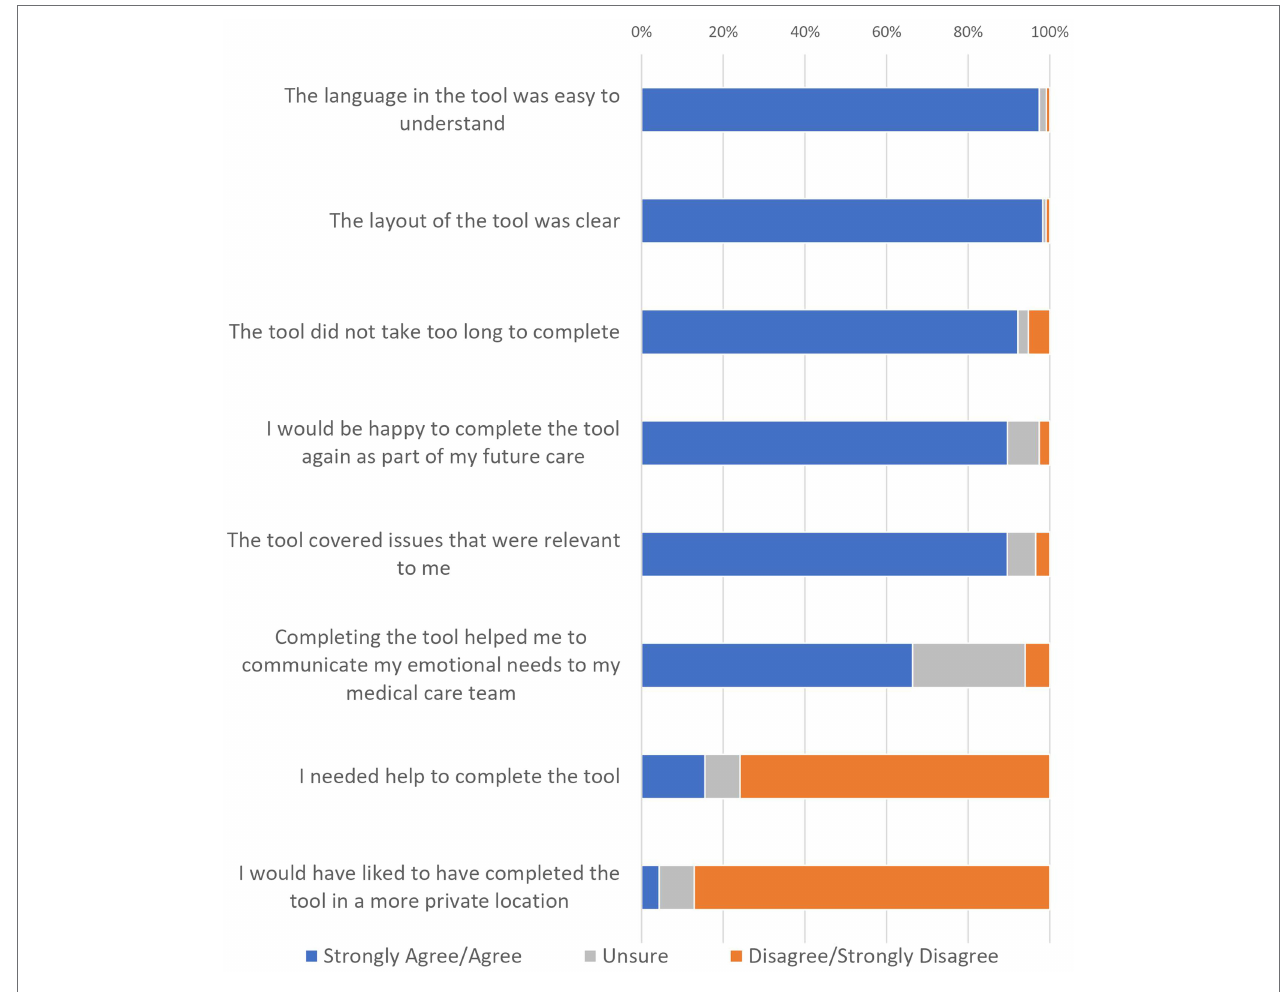
FIGURE 1 | AYA ratings of the acceptability of the